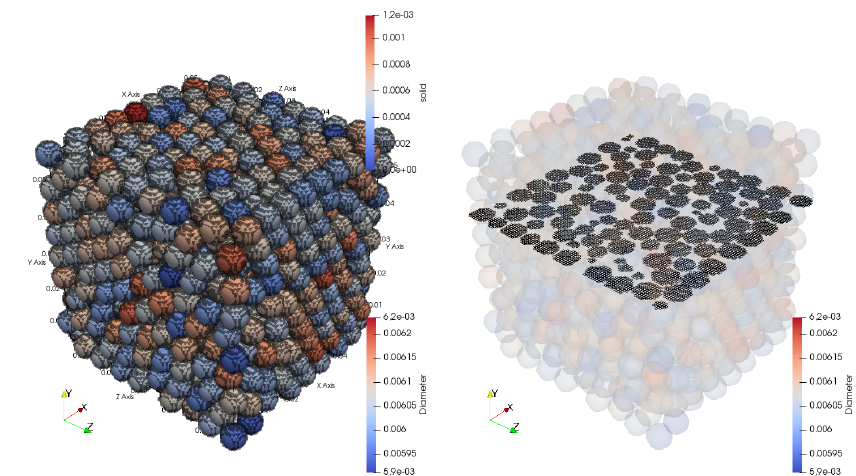
Figure 9. Virtual bed sample number 3 in resolution 100 × 100 × 100.